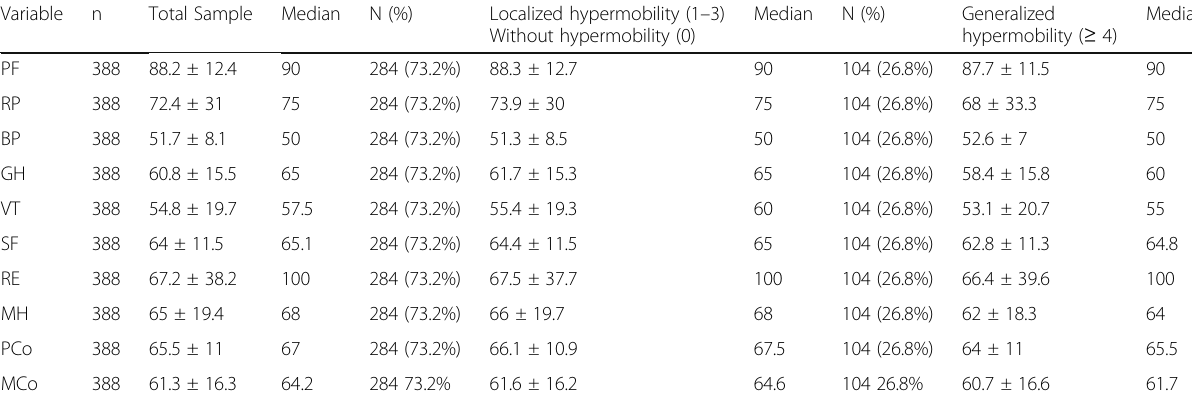
Table 4 Comparison of the SF-36 scores in the total sample of volunteers, without hypermobility (Beighton score = 0) or with localized hypermobility (1 – 3) and generalized hypermobility ( ≥ 4)